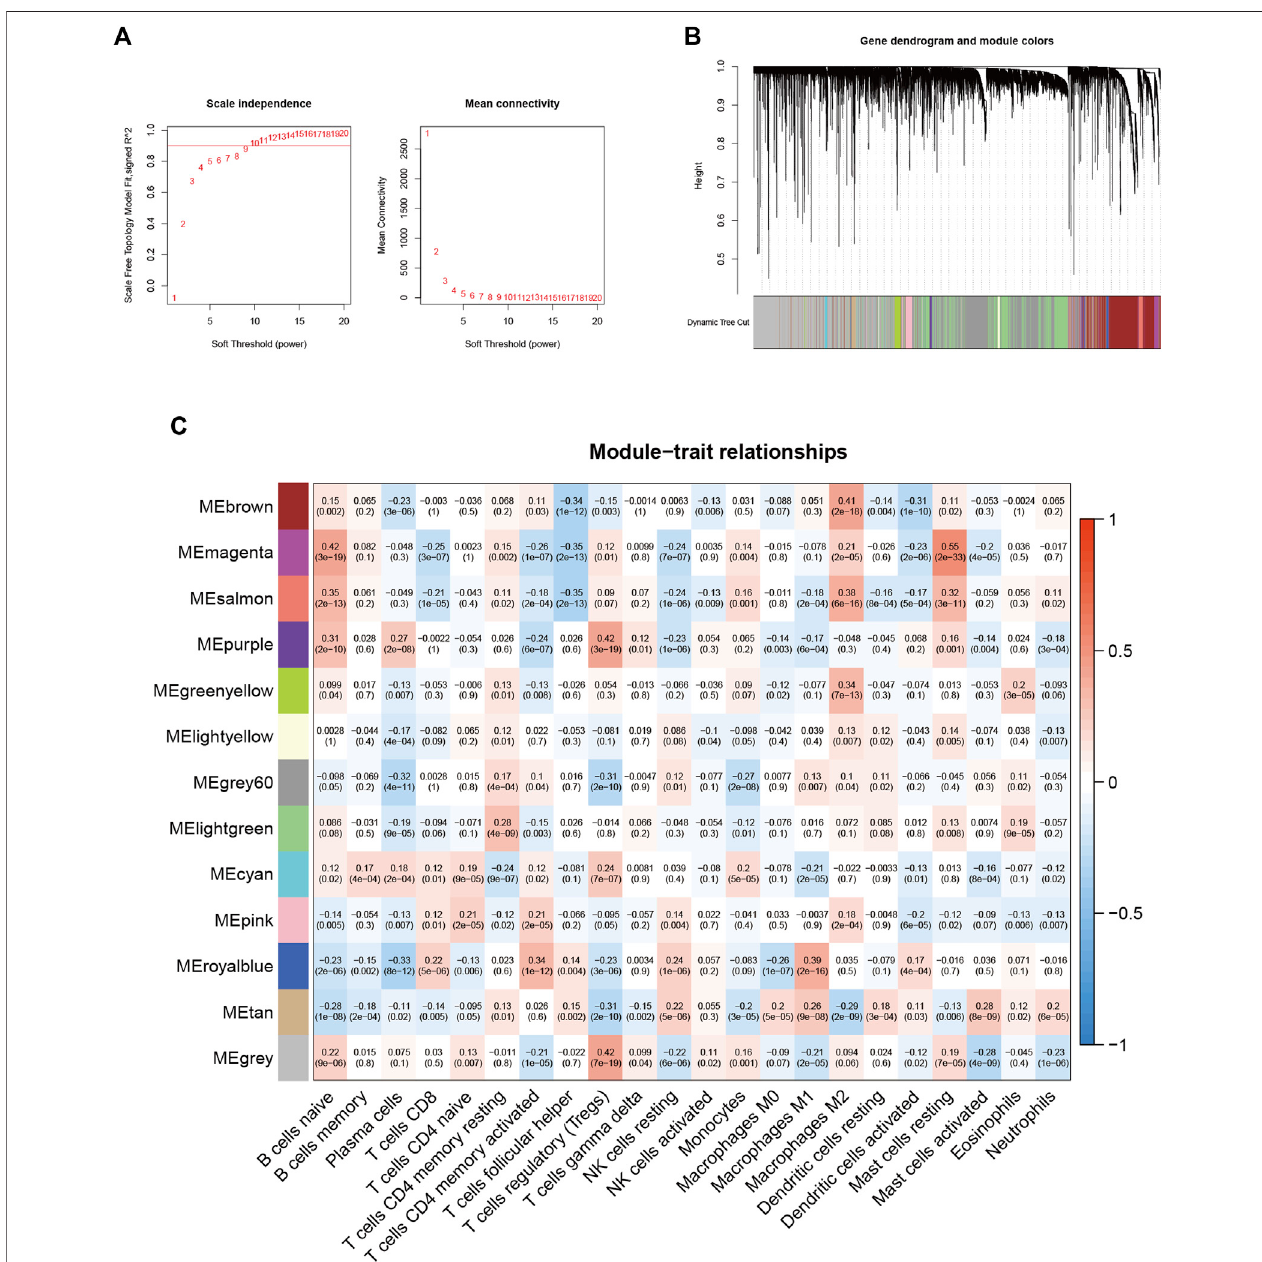
FIGURE 2 | Choosing an appropriate soft threshold (power) and building a hierarchical clustering tree (A) The choice of the soft threshold enables the scale-free topology to achieve an exponent of 0.90, and the average connectivity for 1 – 20 soft threshold powers is analyzed (B) M2 macrophage-related genes with similar expression patterns were merged intothe same moduleusing adynamictree-cutting algorithm, creating ahierarchicalclusteringtree. Heatmap ofcorrelations between (C) modules and immune-in fi ltrating cells (traits).